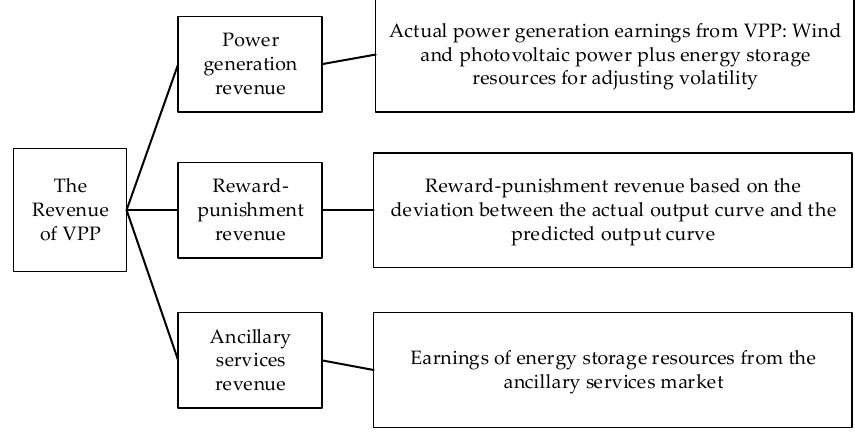
Figure 2. Virtual power plant revenue.